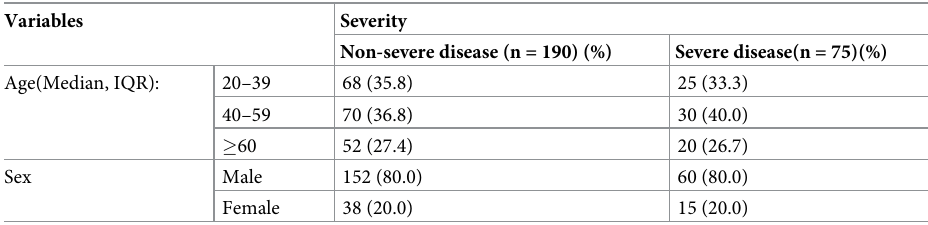
Table 1. Demographic characteristics of study